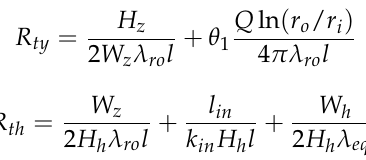
Figure 11. LPTN model of the internal air.